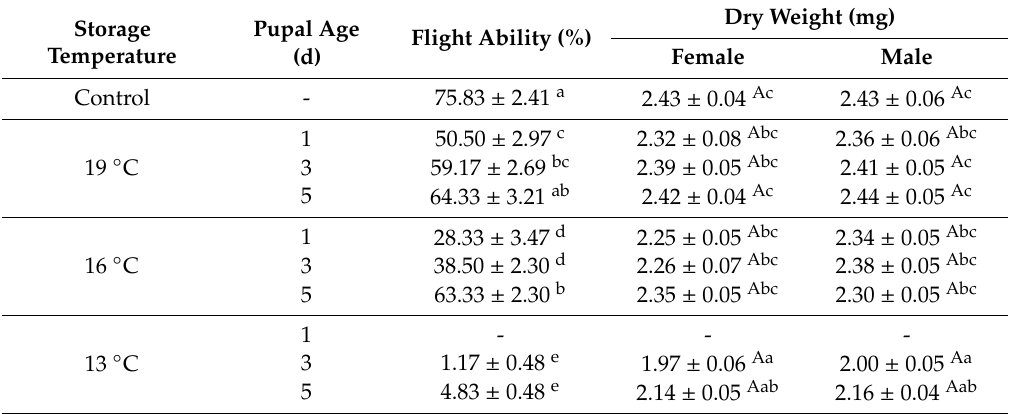
according to Tukey’s honestly significant difference (HSD) test (one-way ANOVA), and value of dry weight in a row followed by the same capital letter does not differ significantly ( p > 0.05)